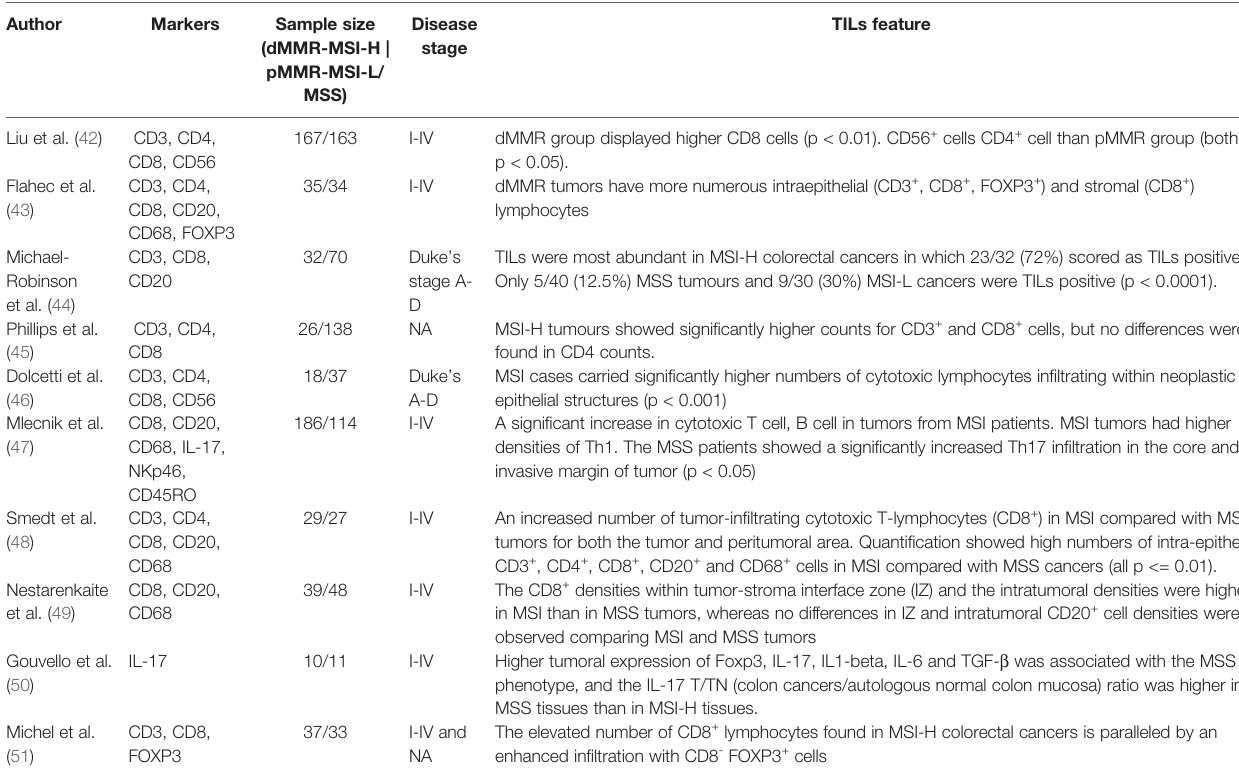
TABLE 1 | The association of tumor in fi ltrating lymphocytes with microsatellite stability status in colorectal